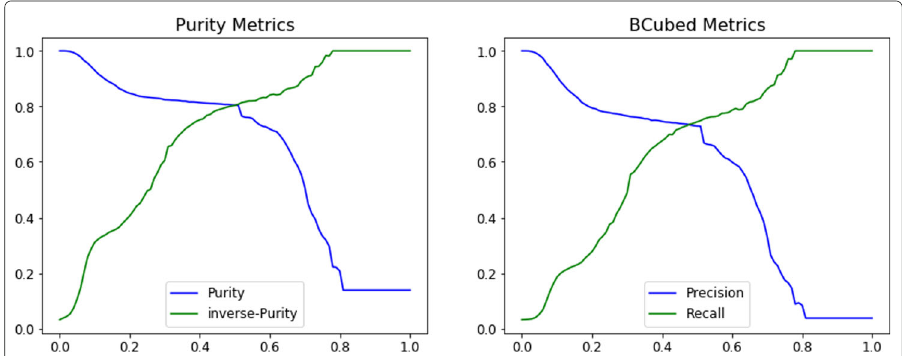
Fig. 5 Precision (purity) and recall (inverse purity) of the top performing semantic frame induction approach on the test data. The horizontal axes refer to the neighboring threshold used to create the edges